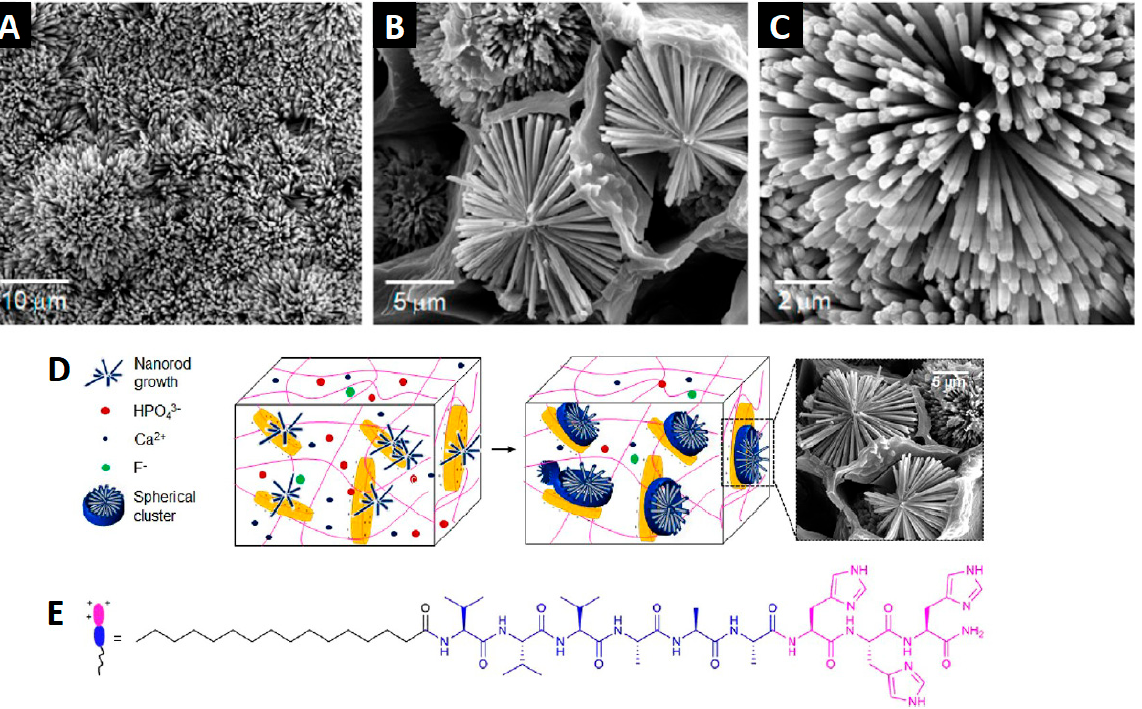
Figure 3. SEM images showing ( A ) dense crystal formation on the surface of a histidine peptide-based clay-hydrogel composite, which are organized into ( B , C ) spherical clusters of nanorods within the cavity of the hydrogels. ( D ) The hydroxyapatite crystals are formed upon the diffusion of the mineralizing ionic species into the histidine-based amphiphile peptide hydrogel loaded with Laponite ® , which triggers the nucleation and hierarchical crystal growth of hydroxyapatite nanorods organized in spherical clusters. ( E ) Chemical structure of the peptide gelator. Adapted from reference [99].